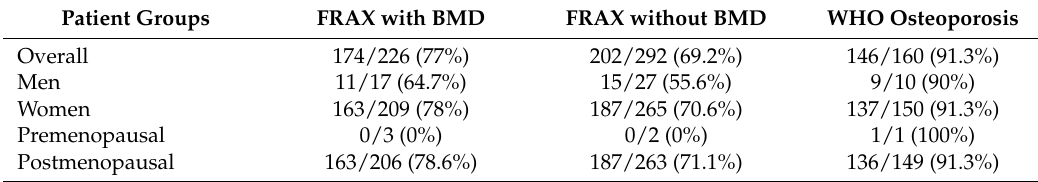
Table 3. Current osteoporosis treatments in high-risk groups according to the FRAX criteria and the WHO osteoporosis